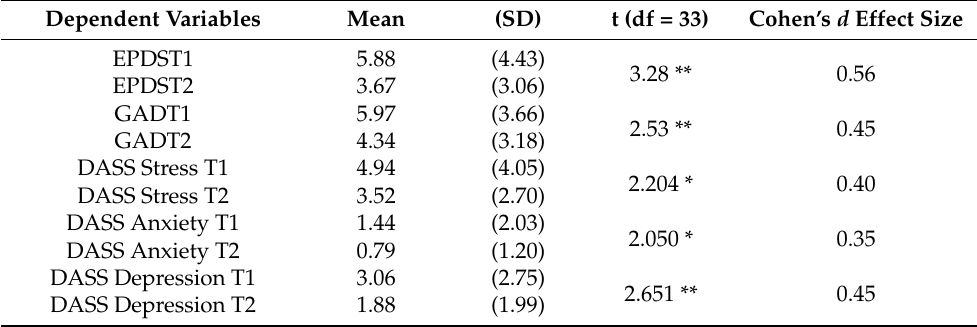
Table 3. Before (T1) and after (T2) comparisons of dependent variables (EPDS, GAD, DASS) ( n = 34). Dependent